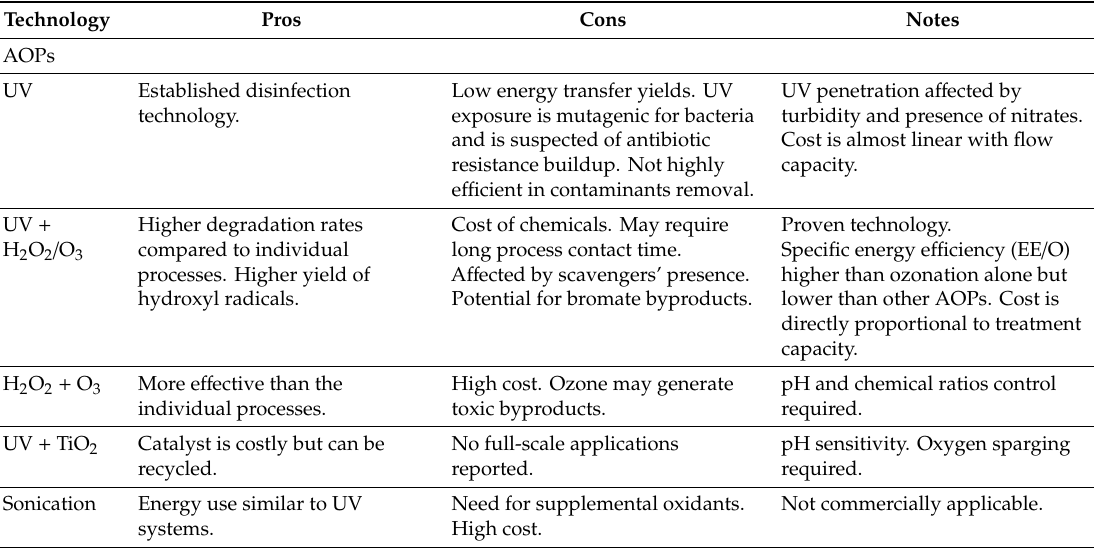
Table 11. Pros and cons of ATP